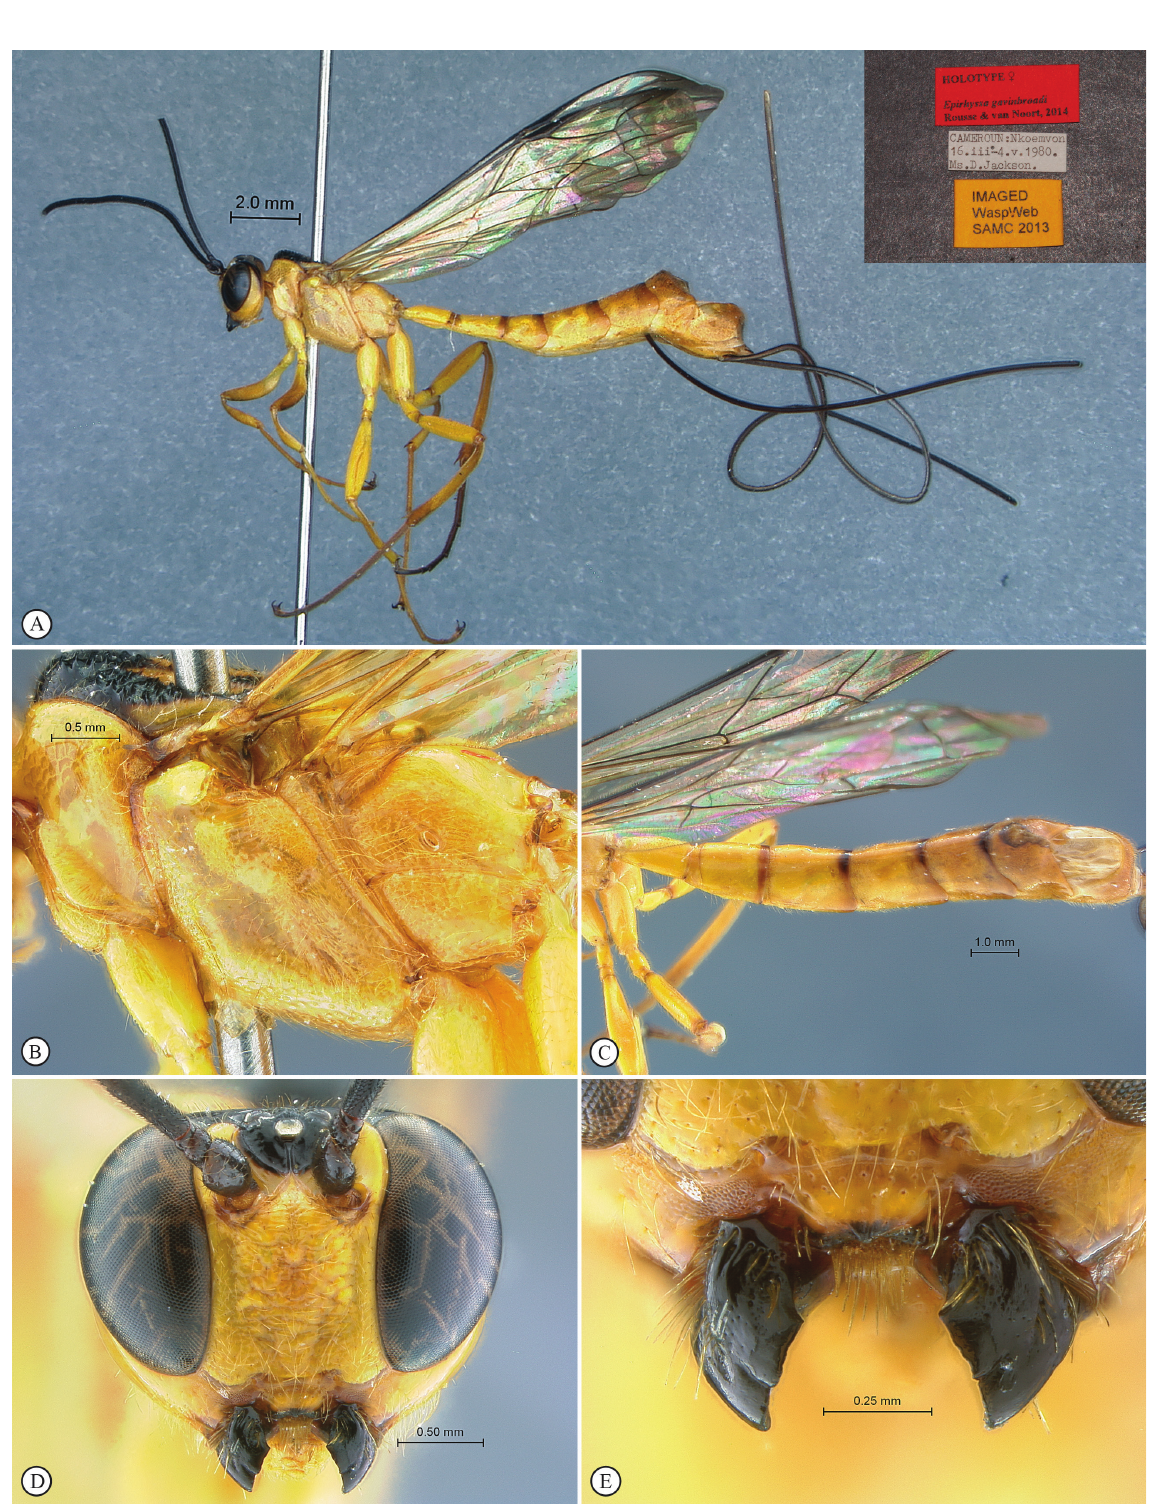
Fig. 2. Epirhyssa gavinbroadi sp. nov., holotype, ♀. A . Habitus, lateral view (inset: data labels). B . Mesosoma, lateral view. C . Metasoma, dorsal view. D . Head, anterior aview. E . Mandibles, anterior